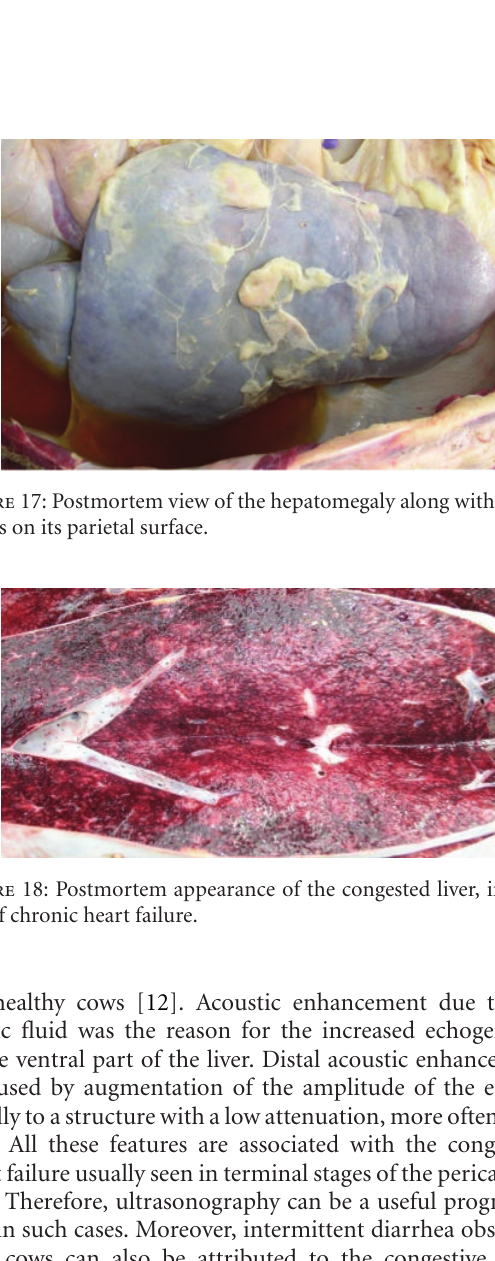
Figure 16: Postmortem view of the ascites.